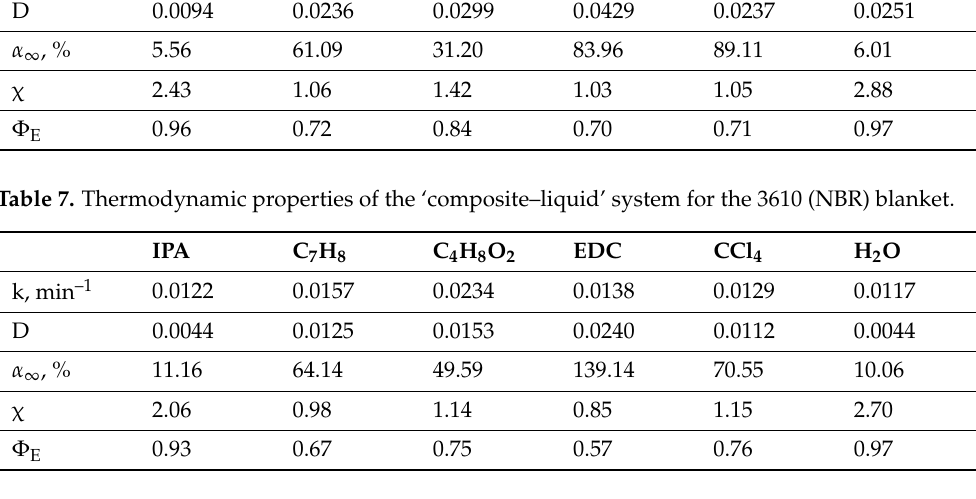
Table 8. Thermodynamic properties of the ‘composite–liquid’ system for the Explorer (NBR) blanket. IPA C 7 H 8